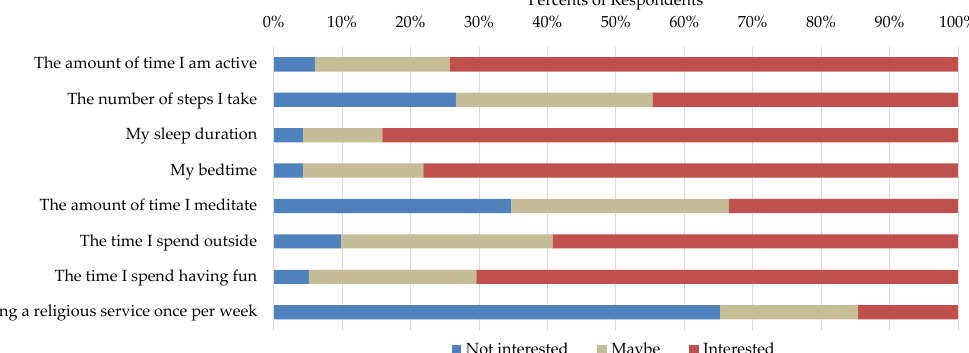
Figure 1. Survey results of self-reported interest in different self-experiments related to productivity. The other outcome measures (happiness, stress, and sleep efficiency) had similar results with sleep duration, bed time was the most popular independent variables, and time spent meditating and attending a religious service were the least